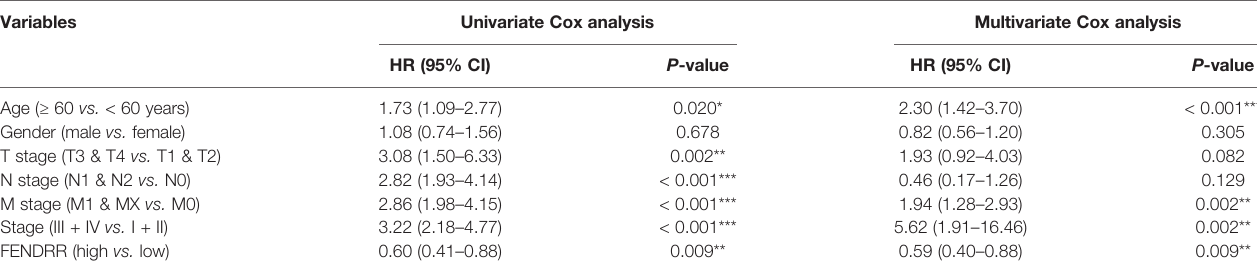
TABLE 2 | Univariate and multivariate Cox analyses of fetal-lethal non-coding developmental regulatory RNA (FENDRR) expression data for the prediction of overall survival (OS). Variables Univariate Cox